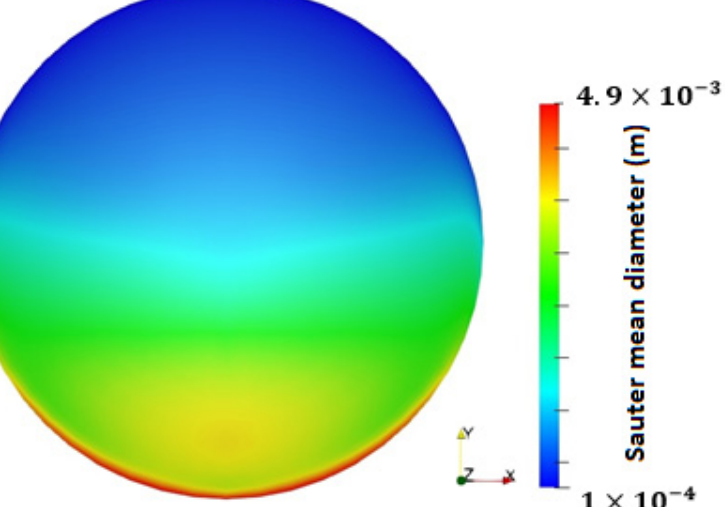
Figure 15. Distribution of Sauter mean diameter (m) across pipe section for test 4 (mixture velocity = 1 m/s, water cut = 0.1).